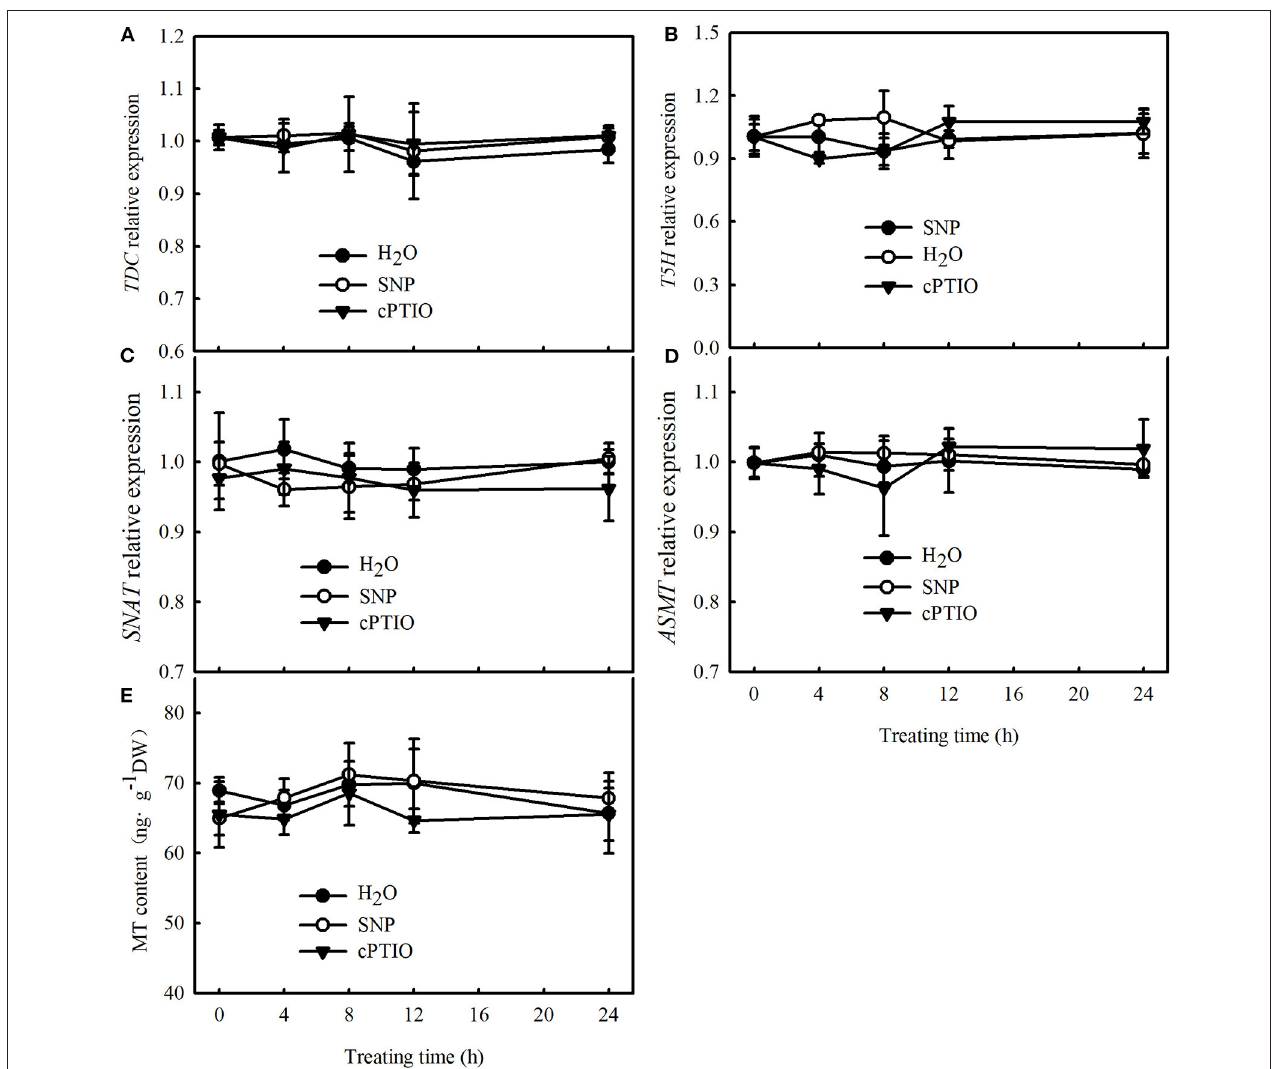
FIGURE 7 | Effects of SNP on MT content and key genes of MT biosynthesis, relative mRNA expression in cucumber seedlings. (A–D) Relative mRNA expression of TDC , T5H , SNAT , and ASMT , respectively; (E) MT content. Three-leaf stage seedlings were foliar sprayed with 75 µ M SNP, 100 µ M 2-(4-carboxyphenyl)-4, 4,5,5-tetramethylimidazoline-1-oxyl-3-oxide (cPTIO) (a NO biosynthetic inhibitor), or distilled water (control) for 24h. Data are represented as mean ± SD ( n =